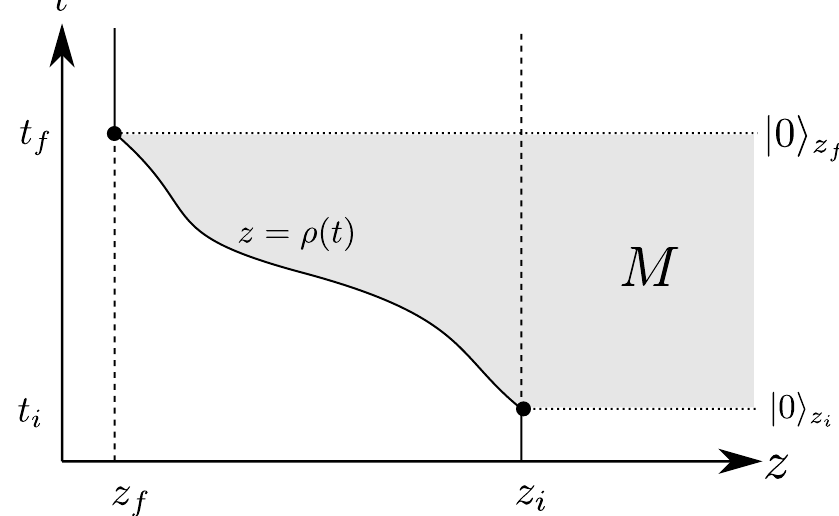
Figure 1 . We consider a subregion M of Euclidean Poincaré AdS 3 . We introduce two time-slices t = t i and t = t f corresponding to the field theory ground states | 0 i z for different values of the radial cutoff. The radial boundary is at finite cutoff, z = ρ ( t ) . Our proposal is that the complexity of the circuit that maps between these ground states with different finite Wilsonian cutoffs is given by the gravitational action on M